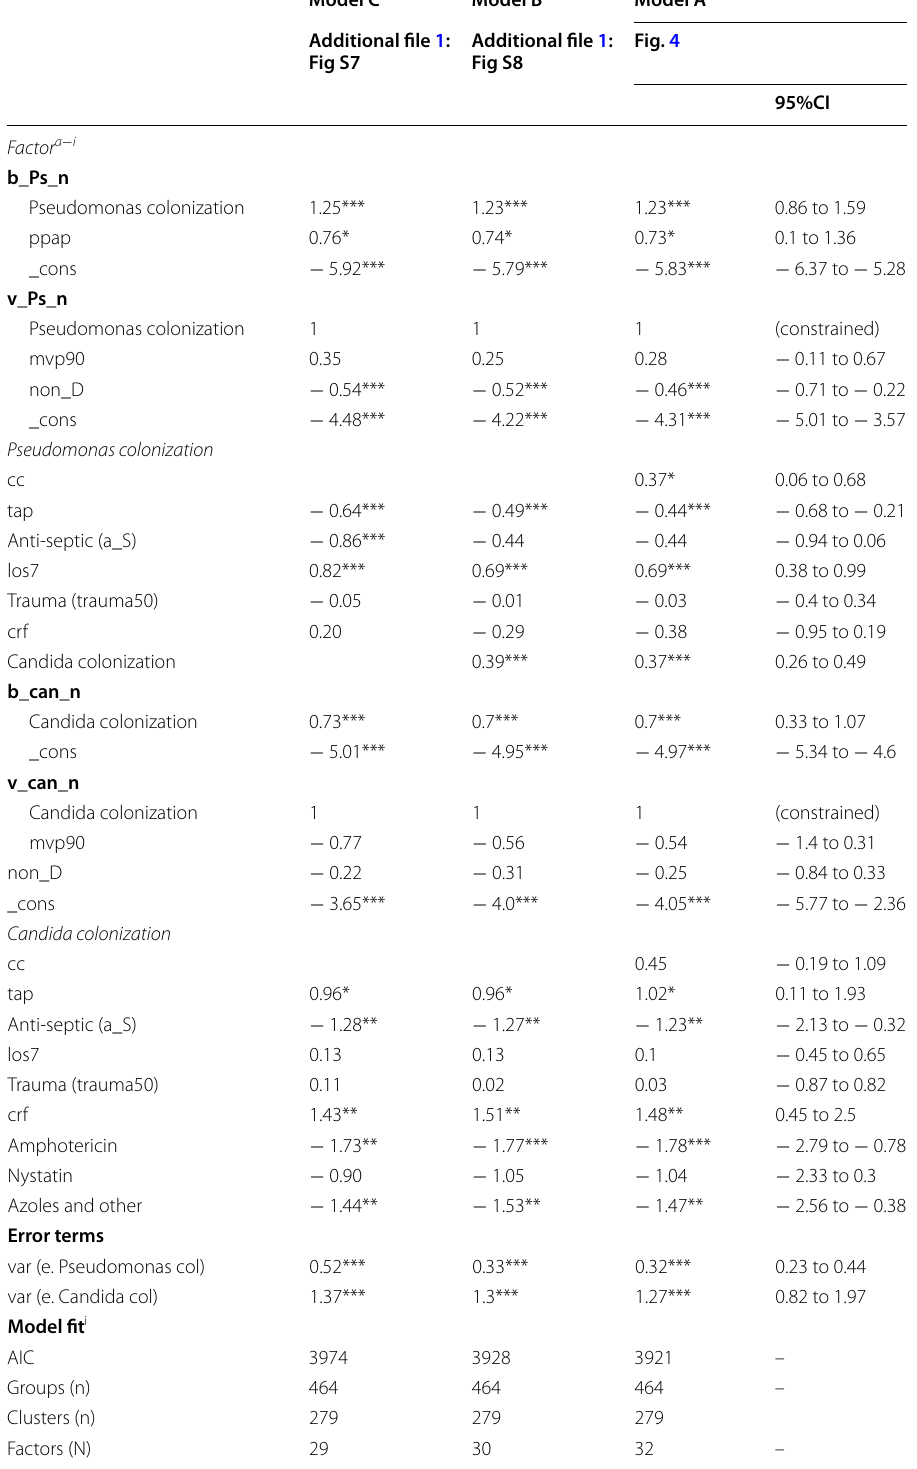
Table 2 Development of GSEM models; model C, model B and model